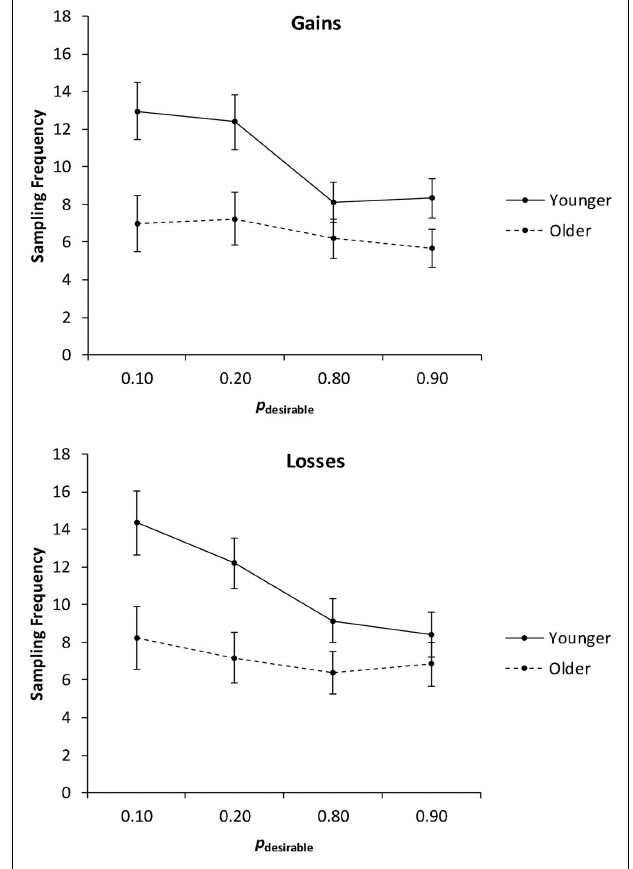
FIGURE 2 | Sampling frequency as a function of valence and the probability of the desirable outcome ( p desirable ), for younger and older adults. Adjusted means for the average level of the covariate (years of education) are shown. Error bars indicate